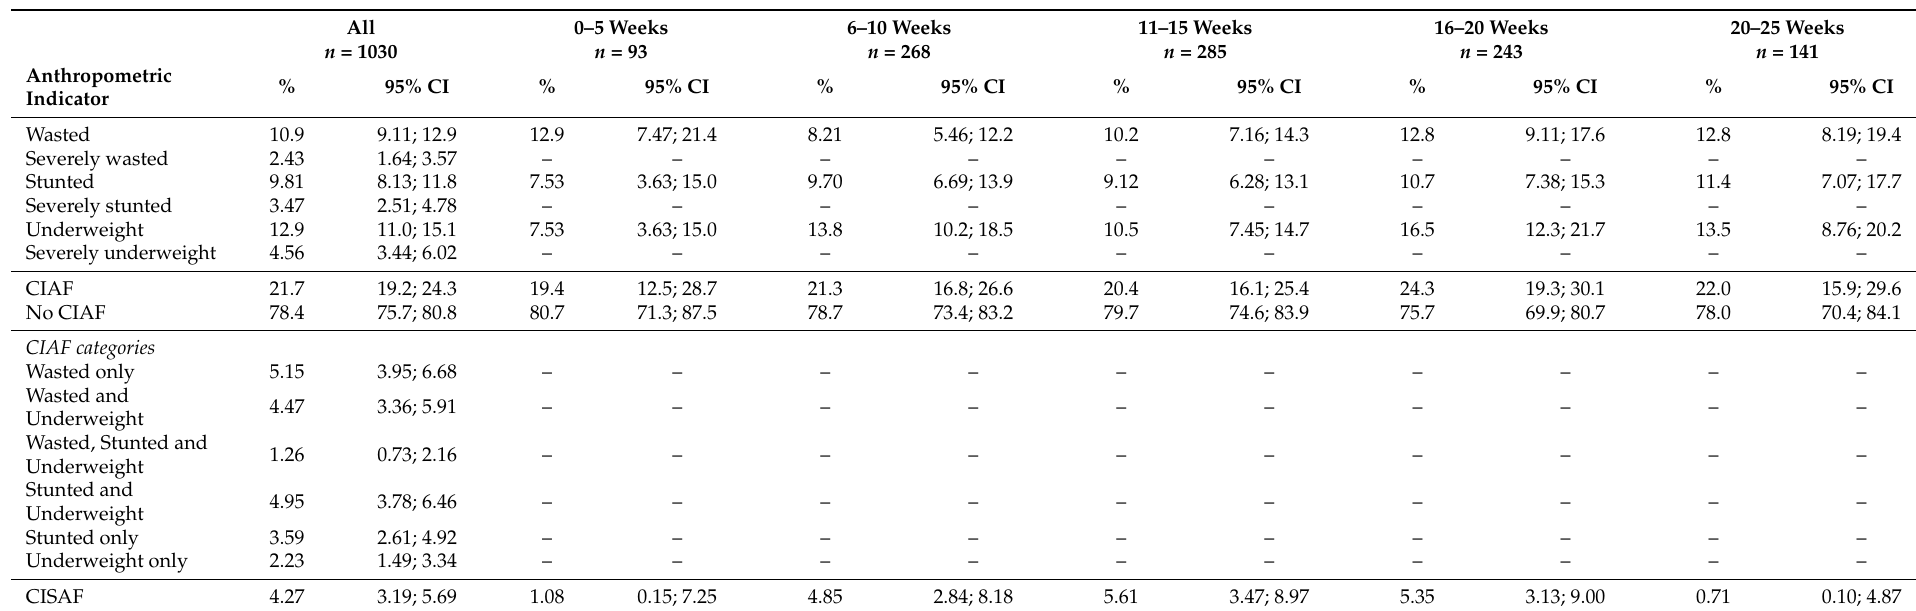
Table 2. Proportion of infants aged under six months with different indicators of anthropometric